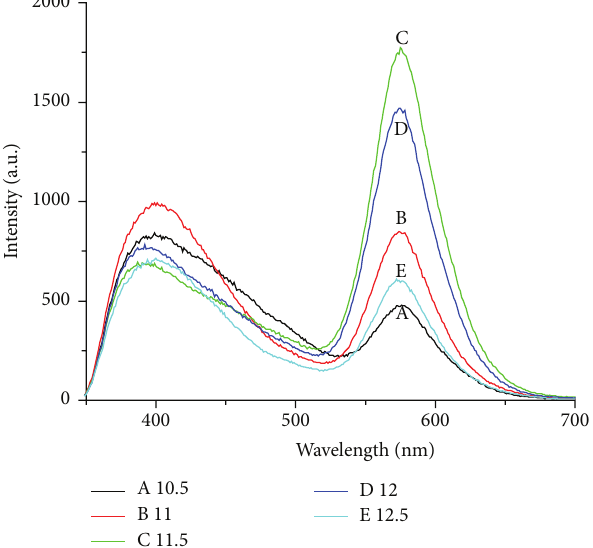
Figure 4: Fluorescence emission spectra of ZnS:Mn 2+ QDs under the different doping level of Mn (from 1.0% to 5.0%). The excitation wavelength for all the samples was fixed at 300 nm.